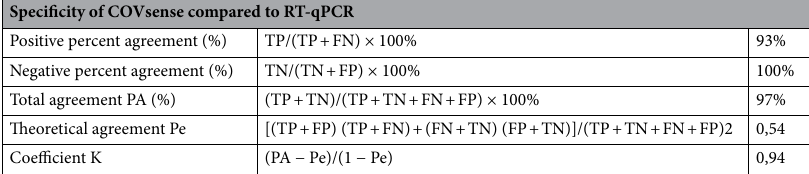
Specificity of COVsense compared to